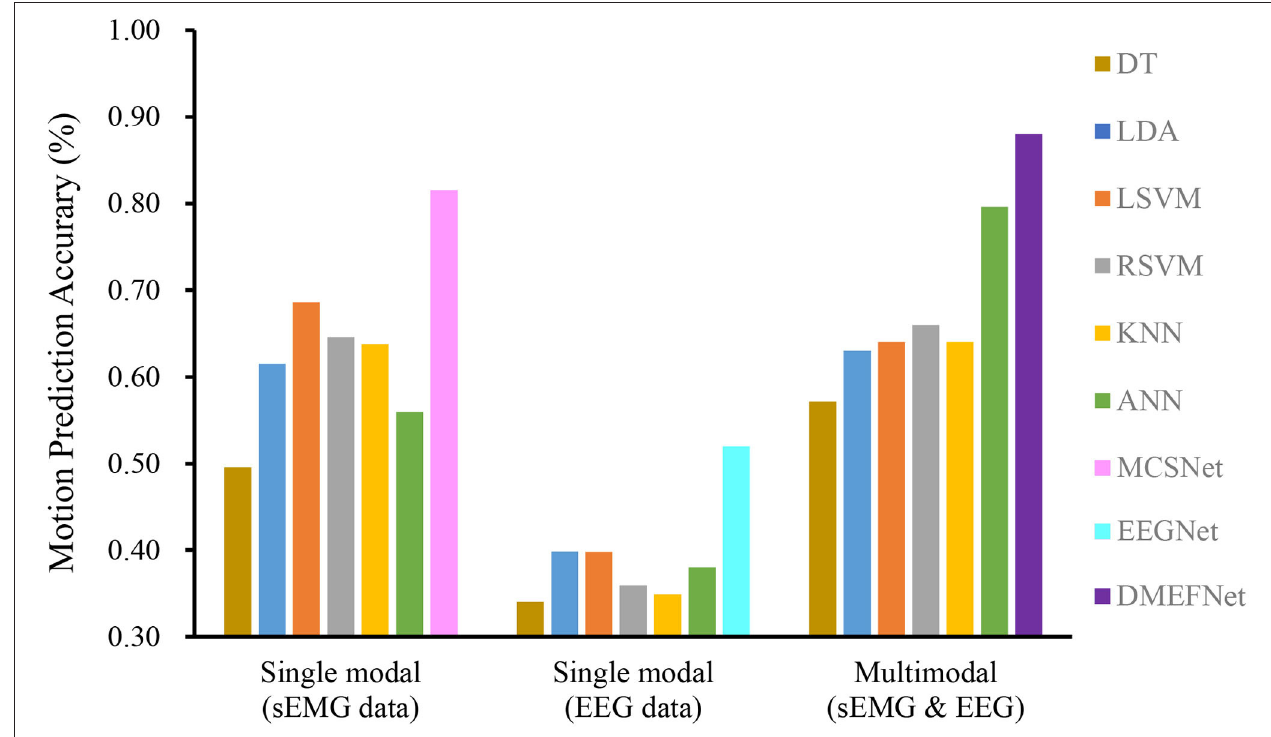
FIGURE 6 | Cross-subject movement prediction performance averaged over all folds. Error bars denote two standard errors of the mean.